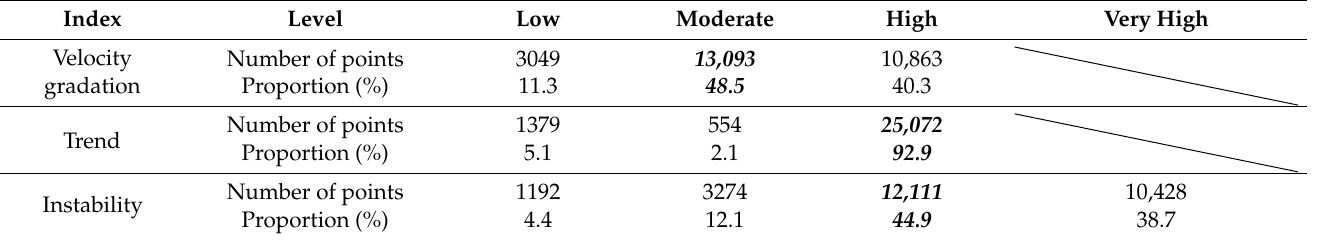
Figure 9. The ( a ) final deformation velocity map calculated by deformation in the vertical direction and horizontal direction, ( b ) deformation velocity gradation results, ( c ) trend estimation results, and ( d ) instability degree of the deformation regions in Lajia Town. Table 3. Basic information and assessment results of the deformation regions in Lajia